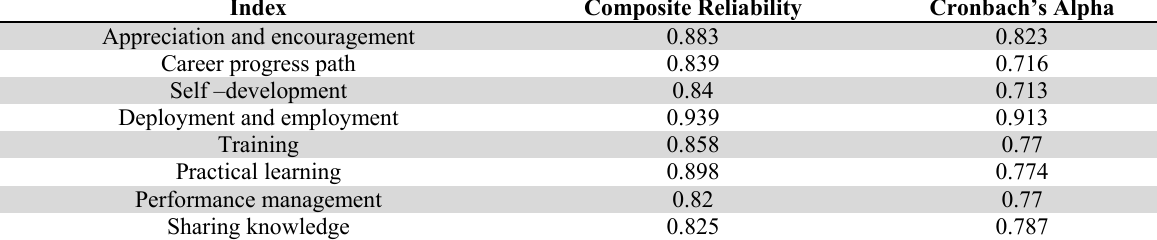
Composite reliability and Cronbach's alpha values for measuring talent development index